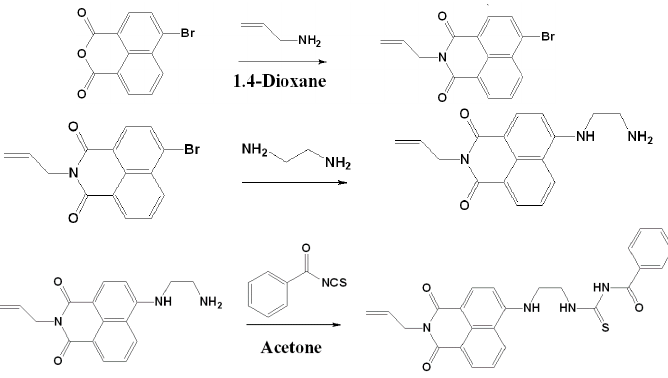
Figure 1. Synthesis of BNPTU fluorescent monomer.